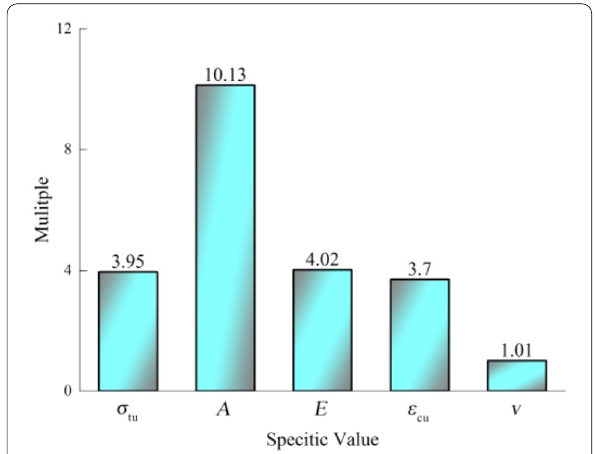
Fig. 11 Comparison histogram of the mechanical